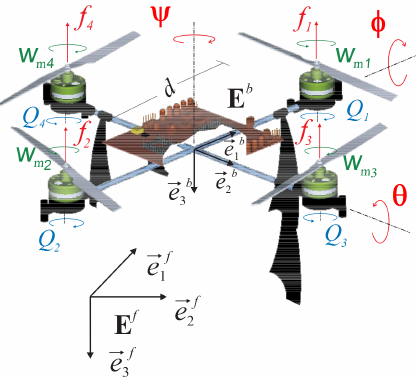
Figure 3. Quadrotor: fixed frame E f = [ (cid:126)e f